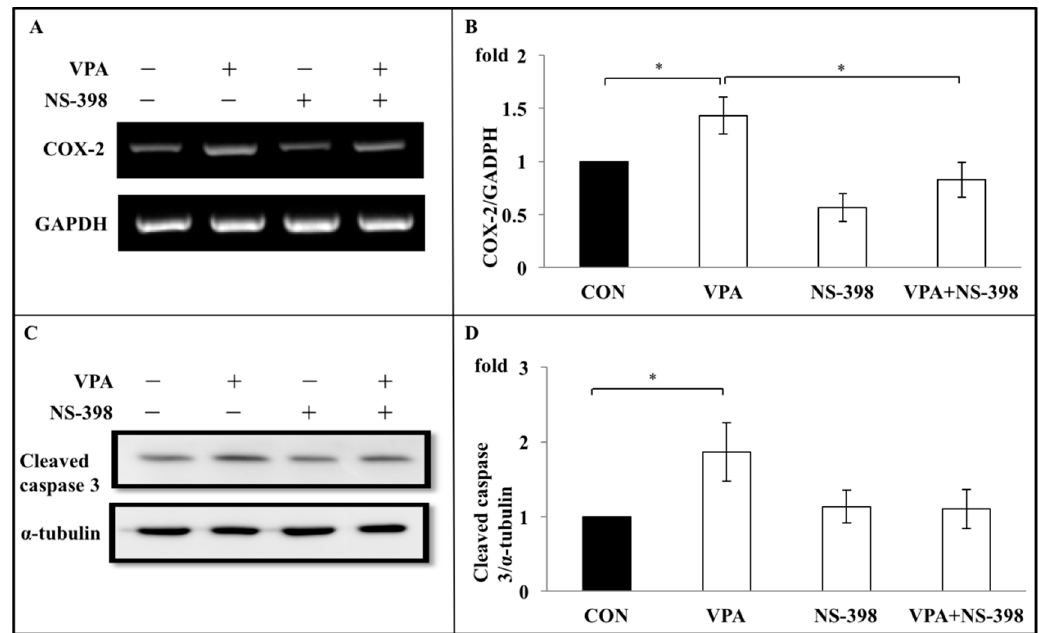
Figure 8. NS-398 abolishes caspase expression increased by VPA. ( A ) A representative gel showed that VPA increasedCOX-2 mRNA expression, while cotreated NS-398 with VPA abolished the increase of COX-2 mRNA expression. NS-398 alone showed no e ff ects on the COX-2 mRNA expression. ( B ) Quantitative data of expression levels of COX-2 mRNA in the experiment in A. All the bars show the mean ± S.E. The bars are (from left), CON (control, culture medium); VPA (valproic acid, 60 µ g / mL); NS-398 (50 µ M); and VPA + NS-398 (valproic acid 60 µ g / mL + NS-398 50 µ M). n = 4 in each experiment. * p < 0.05, ( C ) VPA increased cleaved caspase 3 protein levels, and the increase of the cleaved caspase 3 protein levels was abolished by cotreated NS-398 (50 µ M). NS-398 alone showed no e ff ects on the cleaved caspase 3 protein expression. ( D ) Quantitative data of expression levels of cleaved caspase 3 protein levels in the experiment in C. All the bars showed the mean ± S.D. The bars are (from left), CON (control, culture medium); VPA (valproic acid, 60 µ g / mL); NS-398 (50 µ M); and VPA + NS-398 (valproic acid 60 µ g / mL + NS-398 50 µ M). n = 4 in each experiment. * p < 0.05 .